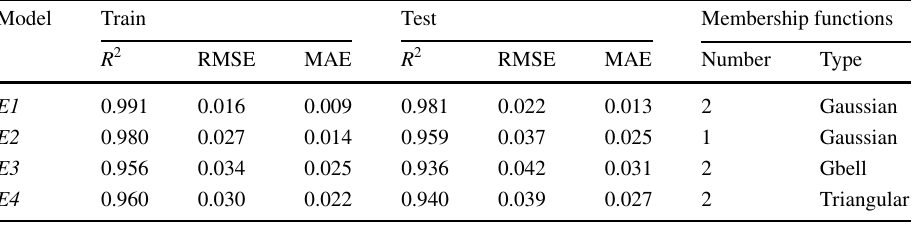
Table 7 Evaluation of input